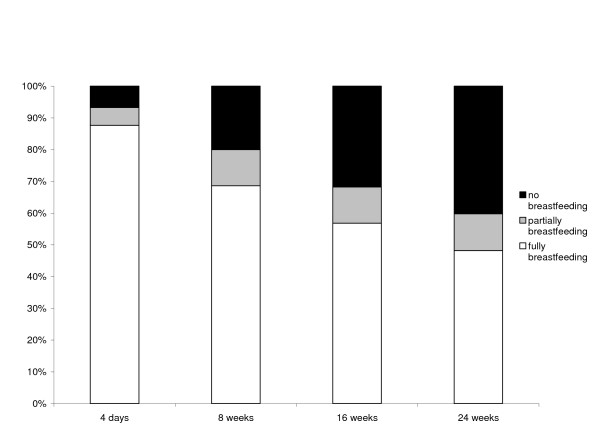
Breastfeeding at 4 days, 8 weeks, 16 weeks and 24 weeks postpartum.